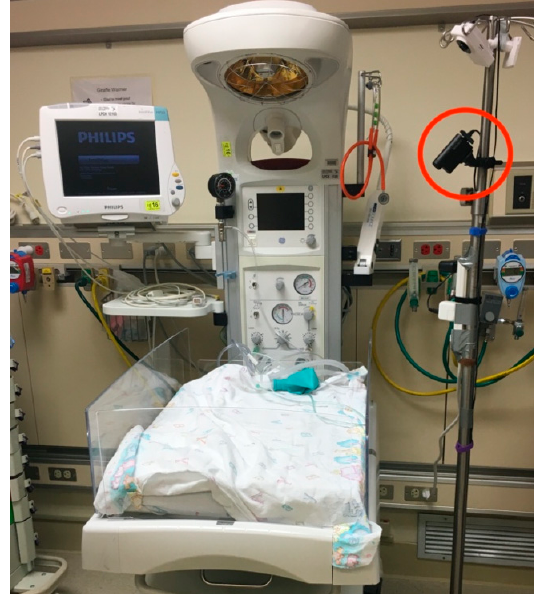
Figure 1. Study setup. Red circle shows camera set up above an open neonatal intensive care units (NICU) crib. The hospital-standard monitor can be seen on the opposite side of the crib as the camera.